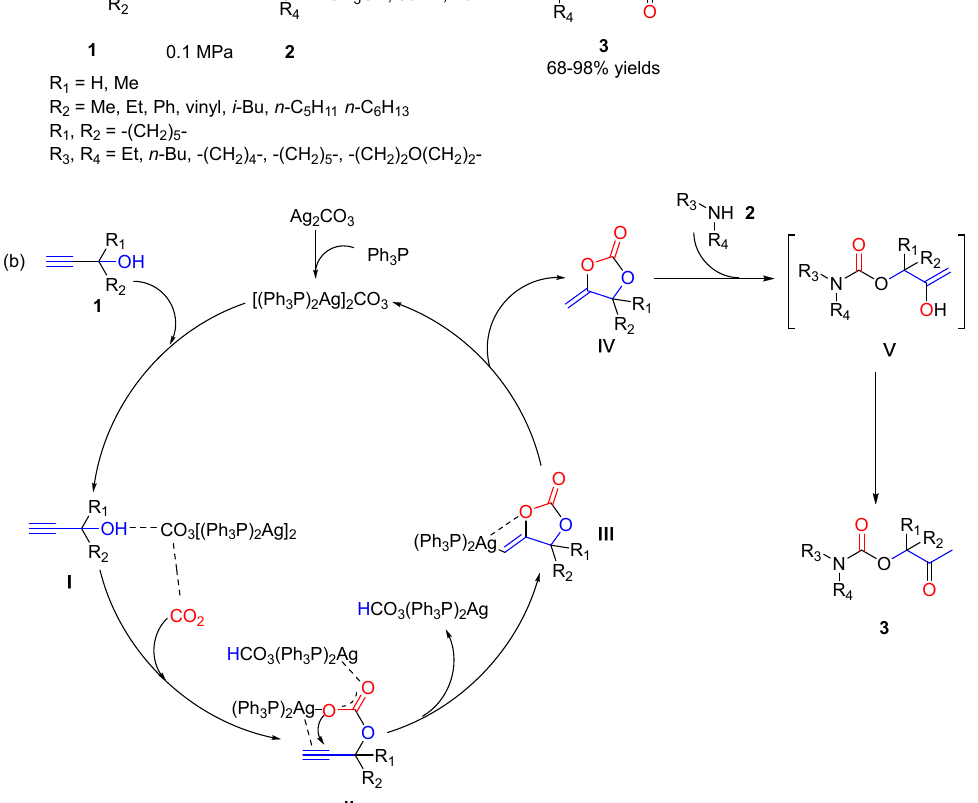
Scheme 21. ( a ) Ag 2 CO 3 /Ph 3 P system catalyzed three-component reaction of propargylic alcohols, CO 2 and secondary amines. ( b ) The proposed catalytic mechanism of the Ag 2 CO 3 /Ph 3 P system.